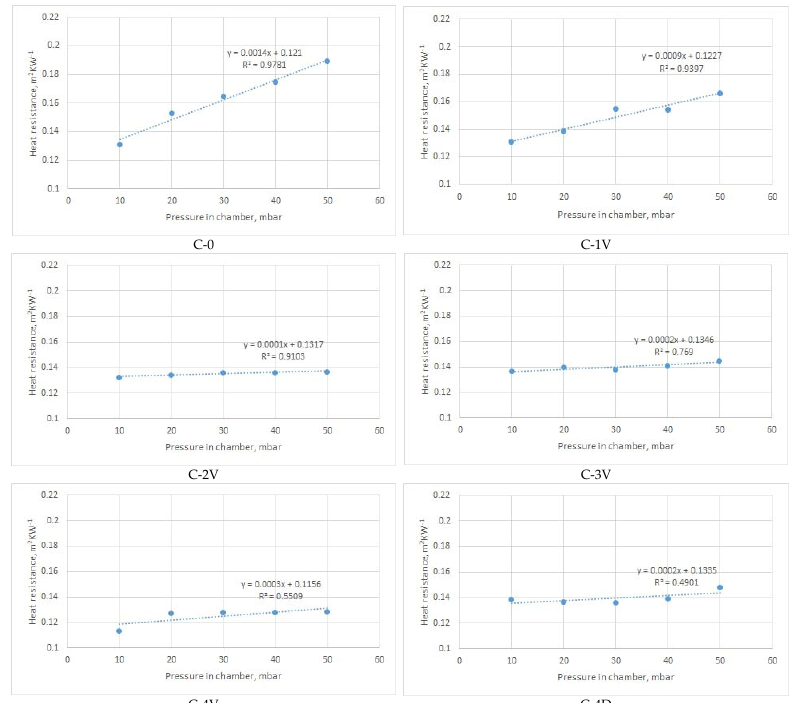
Figure 12. Dependence of heat resistance and air pressure of inflated PICs s at a constant ambient temperature of 20 ◦ C.